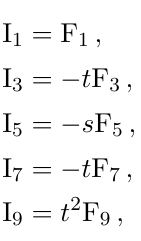
for the (cid:12)rst integral 1 ;:::; 34